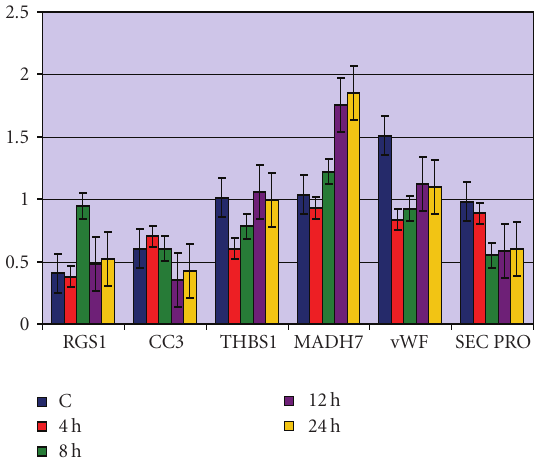
Figure 4: The expression of RGS1, CC3, THBS1, vWF, MADH7, and Sec Pro at 4-, 8-, 12-, and 24-hour time points in irradiated HFL1